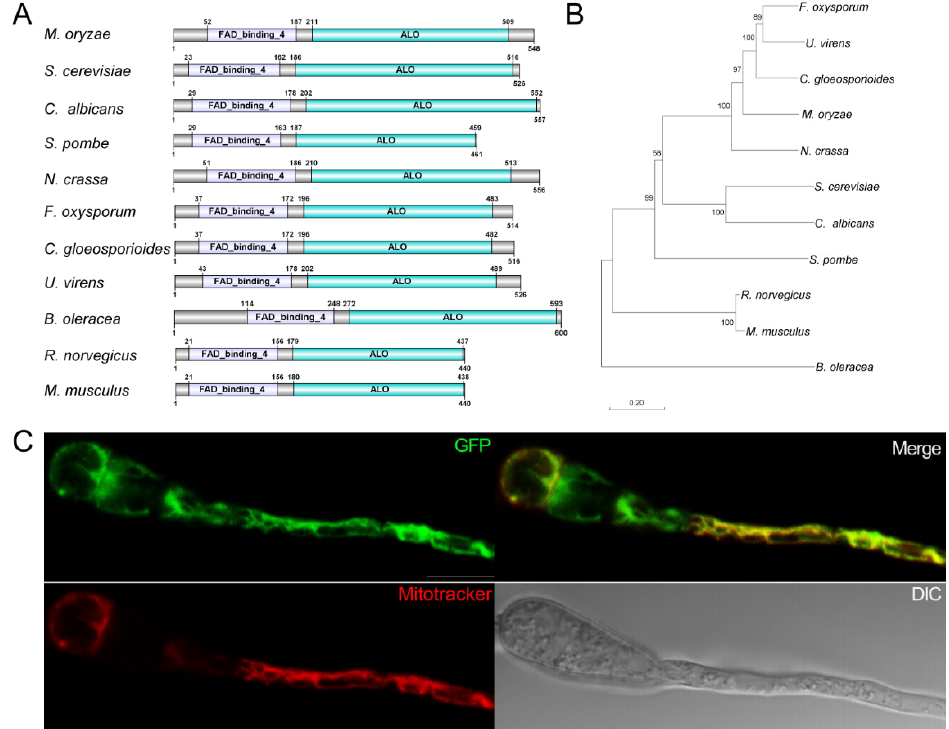
Figure 1. Conserved domains of ALO-containing proteins and the location analysis of MoAlo1. ( A ) Schematic diagram of ALO-containing proteins in different organisms. The SMART program (http://smart.embl-heidelberg.de, accessed on 1 November 2021) was used to perform the sequence analysis. Among filamentous fungi, plants, and mammals, ALO and FAD_binding_4 domains are conserved. Genbank number: Saccharomyces cerevisiae (NP_013624.1), Candida albicans (KGQ99802.1), Schizosaccharomyces pombe (NP_593526.1), Neurospora crassa (XP_965288.1), Fusarium oxysporum (KAF5266425.1), Colletotrichum gloeosporioides (KAF3807304.1), Ustilaginoidea virens (XP_042995658.1), Brassica oleracea (XP_013629960.1), Rattus norvegicus (NP_071556.2), and Mus musculus (NP_848862.1). ( B ) Phylogenetic analysis and classification of MoAlo1 and homologues proteins in different organisms. The phylogenetic tree was established with full sequences using the Neighbor-Joining method with 1000 bootstrap replications. ( C ) The subcellular localization of MoAlo1. The conidia and germ tube were stained with 100 nM MitoTracker ® Red CMXRos (Invitrogen, California, USA) and observed under a fluorescence microscope. Bar = 10 μ m.